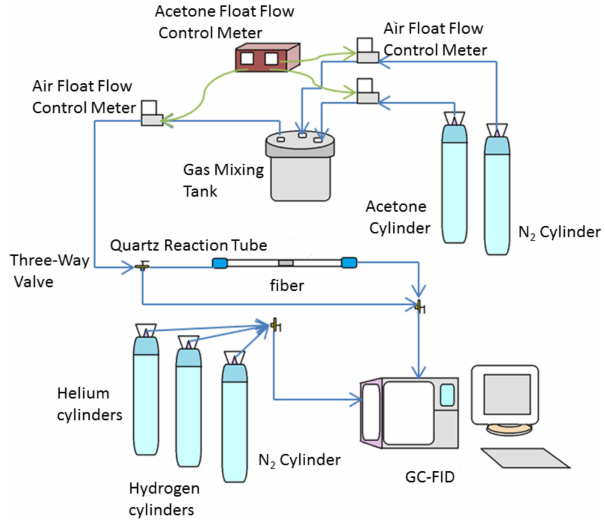
Figure 1. Diagram of performance assessment